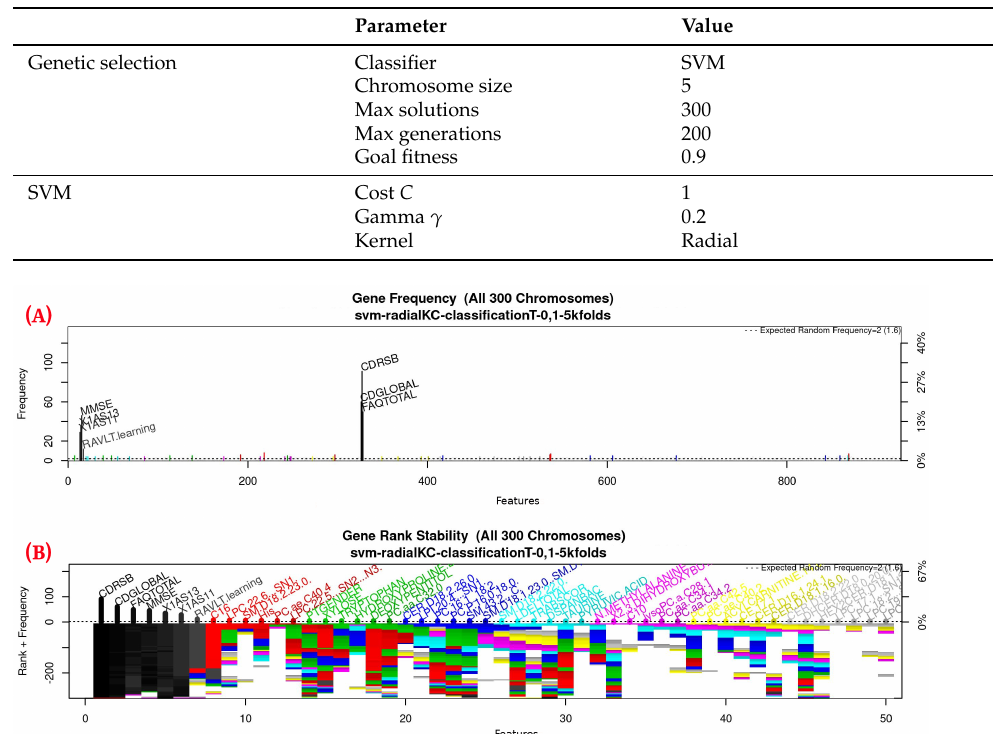
Figure 3. Gene frequency and rank in the models determined by implementing GA using the parameters in Table 3 for the selection of the top features in the dataset. ( A ) Gene frequency shows the number of times that a feature has been present in the models. ( B ) Gene rank shows the stability and frequency of each feature within the models, ordered by rank. For a zoomed view see Figure